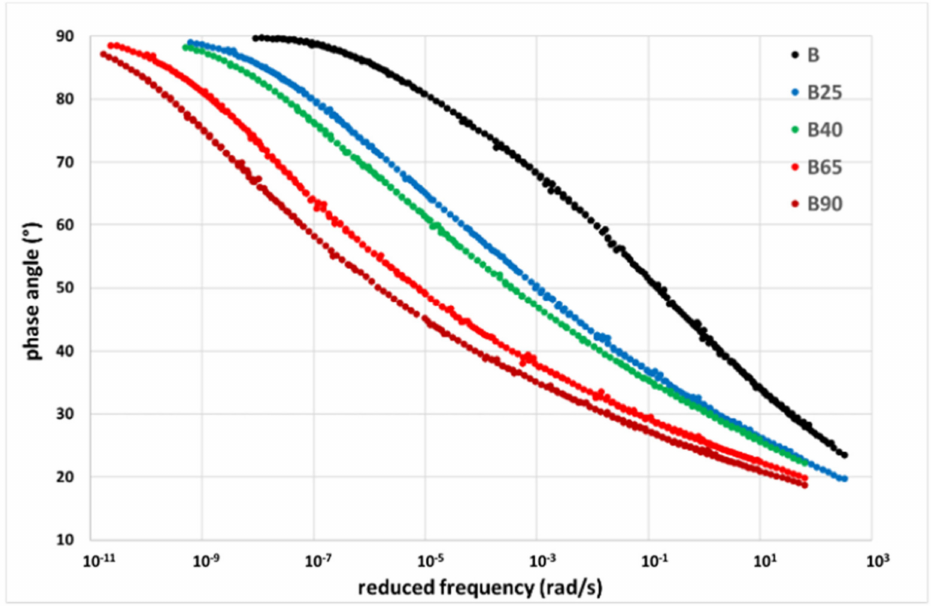
Figure 2. Phase-angle master curves for neat binder B before and after different levels of aging. Reference temperature 0 ◦